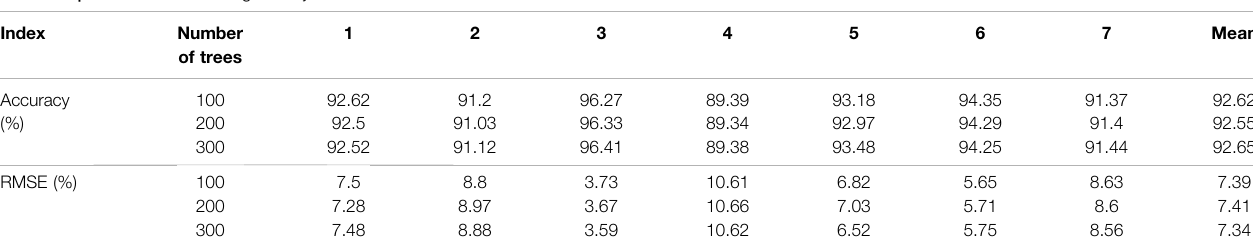
TABLE 3 | Forecast results using 30-days historical